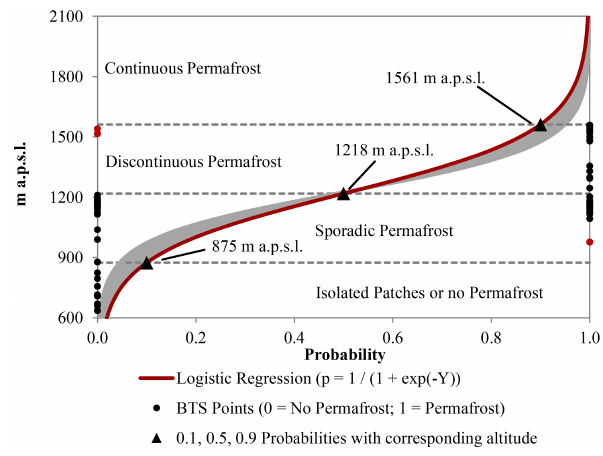
Figure 4. Permafrost probability in relation to altitude: the prob- ability is based on a logistic regression model with the altitude as single independent variable. The grey corridor shows the range of the permafrost probability if outliers (red dots) are removed from the